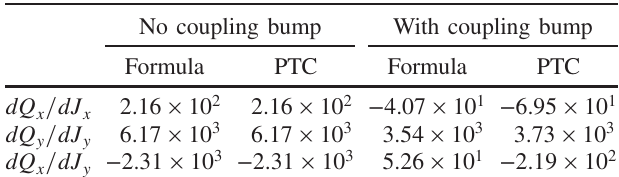
TABLE III. Amplitude detuning from a single octupole within the coupling bump in arc 12 with increased levels of local coupling.